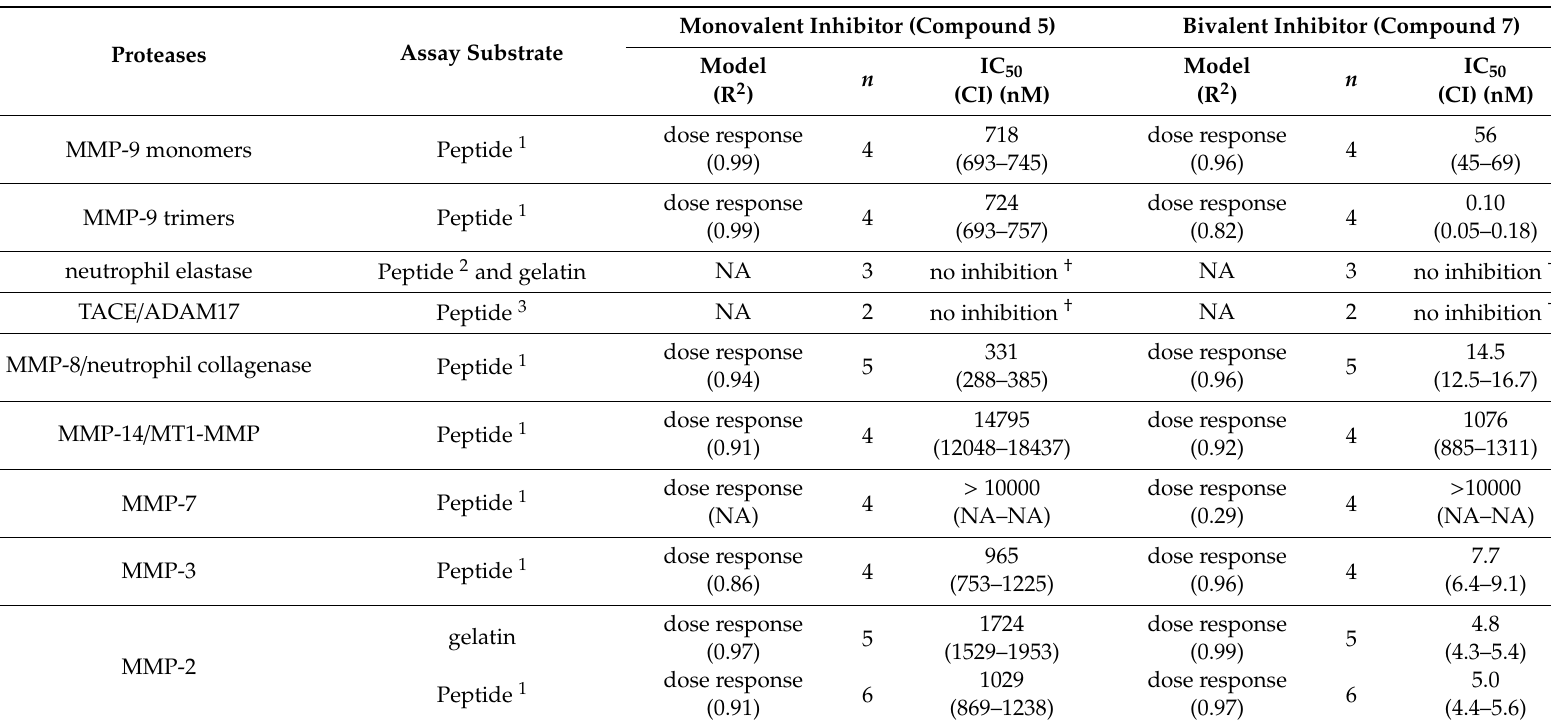
Table 2. Inhibitory capacity of monovalent and bivalent carboxylate inhibitors 5 and 7 on proteases with importance for acute inflammation.